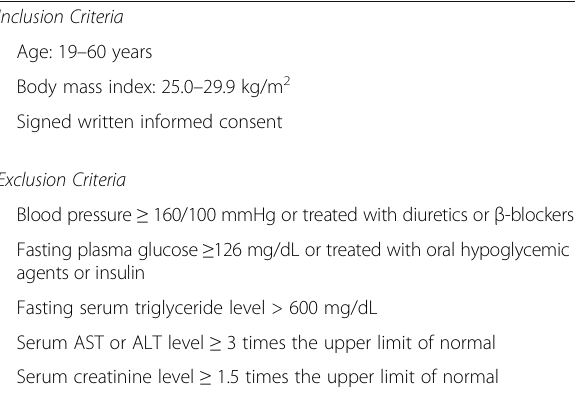
Table 1 Inclusion and exclusion